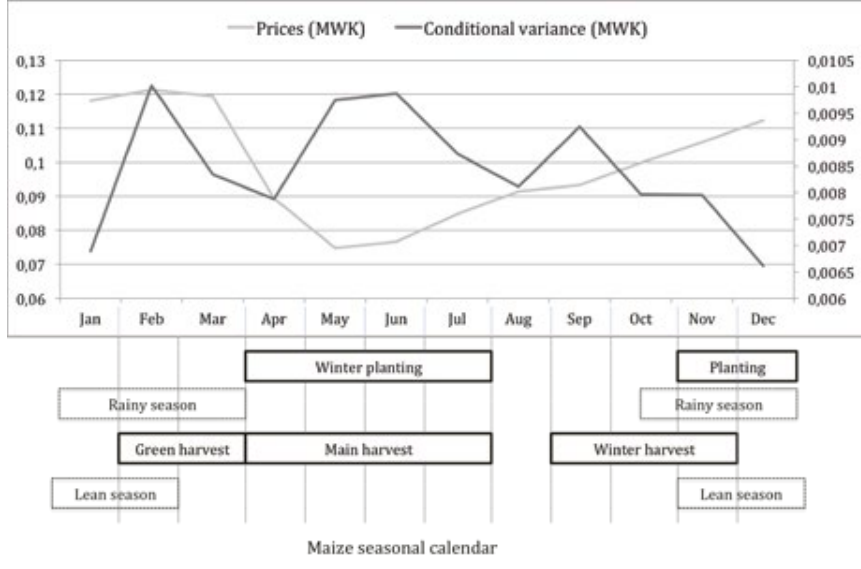
Figure 3. Yearly average maize price and conditional variance of the unpredictable component of maize price in Malawi by month and the maize seasonal